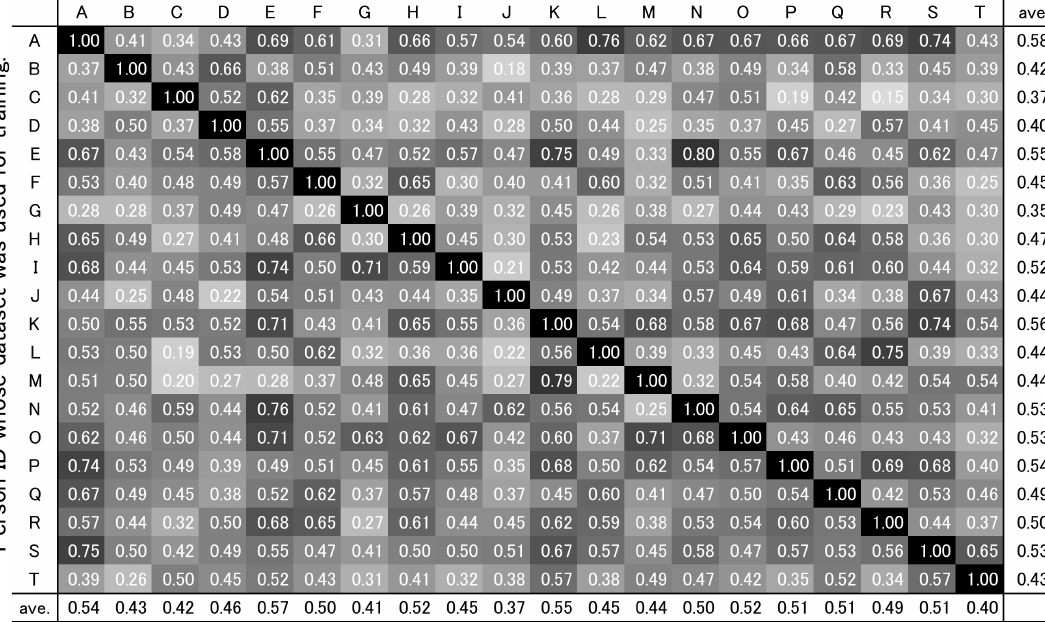
Compatibility matrix of the accuracy obtained by training and testing with person-by-person. Person ID whose dataset was used for